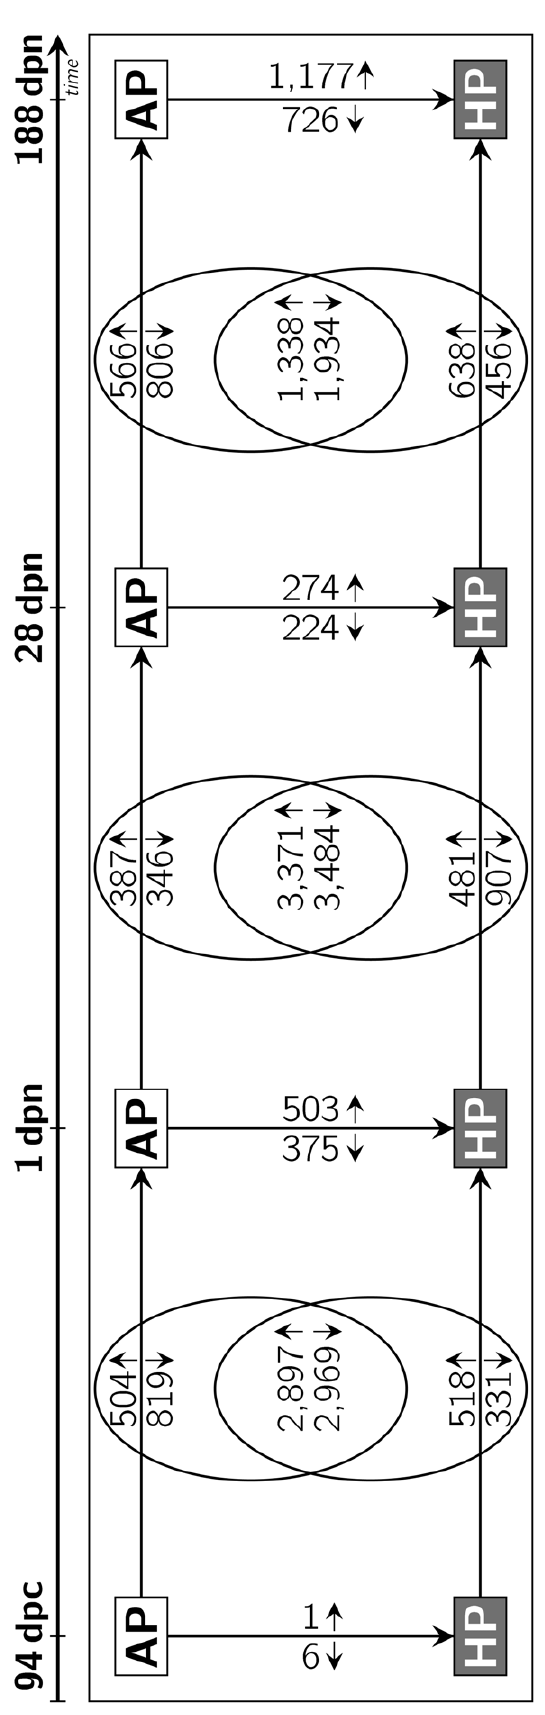
Figure 1. Number of regulated probe-sets in liver tissue. The numbers at the horizontal arrows indicate the quantity of probe-sets significantly regulated between the adjacent ontogenetic stages in either AP or HP offspring, whereas the numbers in the intersections indicate the quantity of probe-sets commonly regulated between stages in AP and HP offspring. The numbers at vertical arrows are the number of probe-sets differentially expressed between AP and HP offspring at the same ontogenetic stage (arrows between boxes show direction of the comparisons; small arrows to top=up-regulated, small arrows to bottom=down-regulated